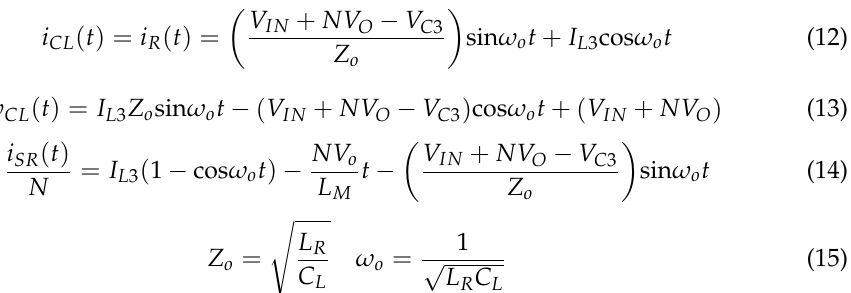
Figure 8. Equivalent circuit in state 3.